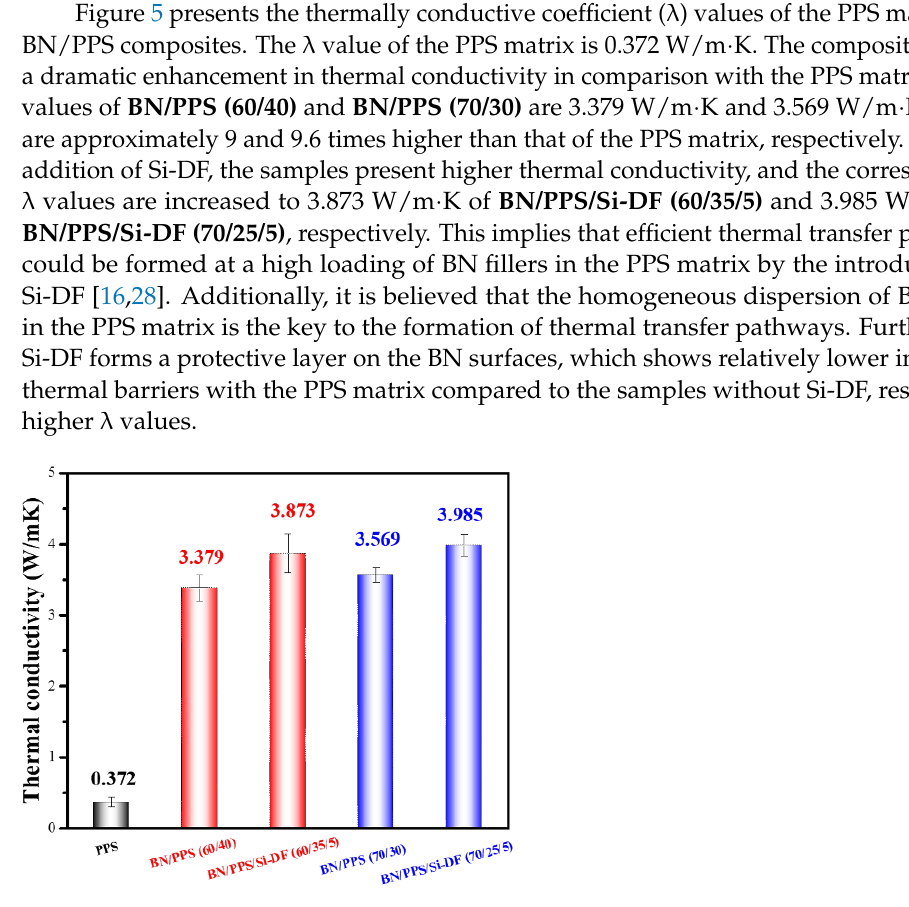
Figure 5. Thermal conductivity of PPS matrix and BN/PPS composites.